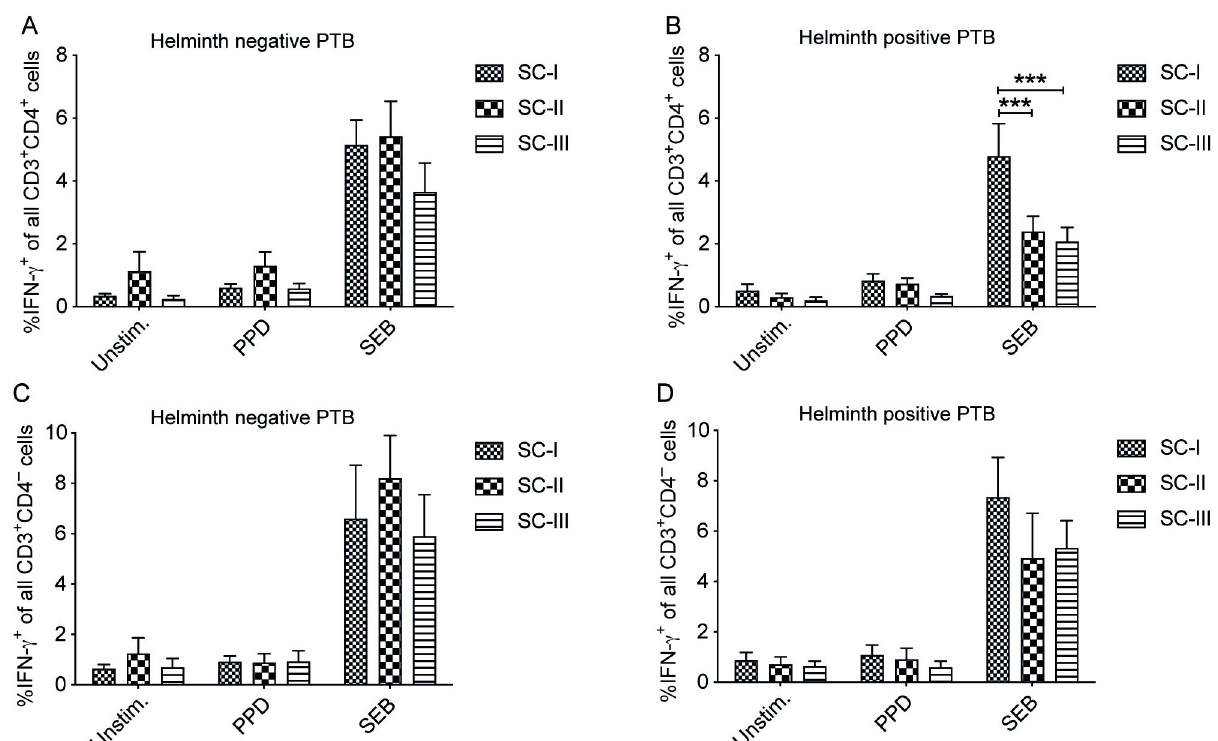
Fig 6. Reduced capacity for IFN- γ production in CD4 + T cells of helminth infected PTB patients having intermediate and sever clinical course of TB. Unstimulated, PPD and SEB stimulated PBMCs were incubated with Brefeldin A ex vivo to analyze intracellular IFN- γ expression in CD3 + CD4 + and CD3 + CD4 - T cells by flow cytometry. Frequency of IFN- γ + CD4 + T cells of all CD3 + CD4 + cells in helminth negative PTB patients (A) and combined A . lumbricoides + , S . mansoni + and hookworm + PTB patients (helminth positive PTB) (B). The frequency of IFN- γ + CD4 - T cells of all CD3 + CD4 - T cells in helminth negative PTB patients (C) and helminth positive PTB patients (D). Data presented as mean ± SEM in three disease severity classes (SCI, n = 14/ 10; SCII, n = 10/10; and SCIII, n = 13/10 in helminth negative/positive PTB patients respectively). Two-way ANOVA with Bonferroni posttest was used to compare differences between different severity classes of H - PTB and H + PTB patients. ��� , p < 0.001.